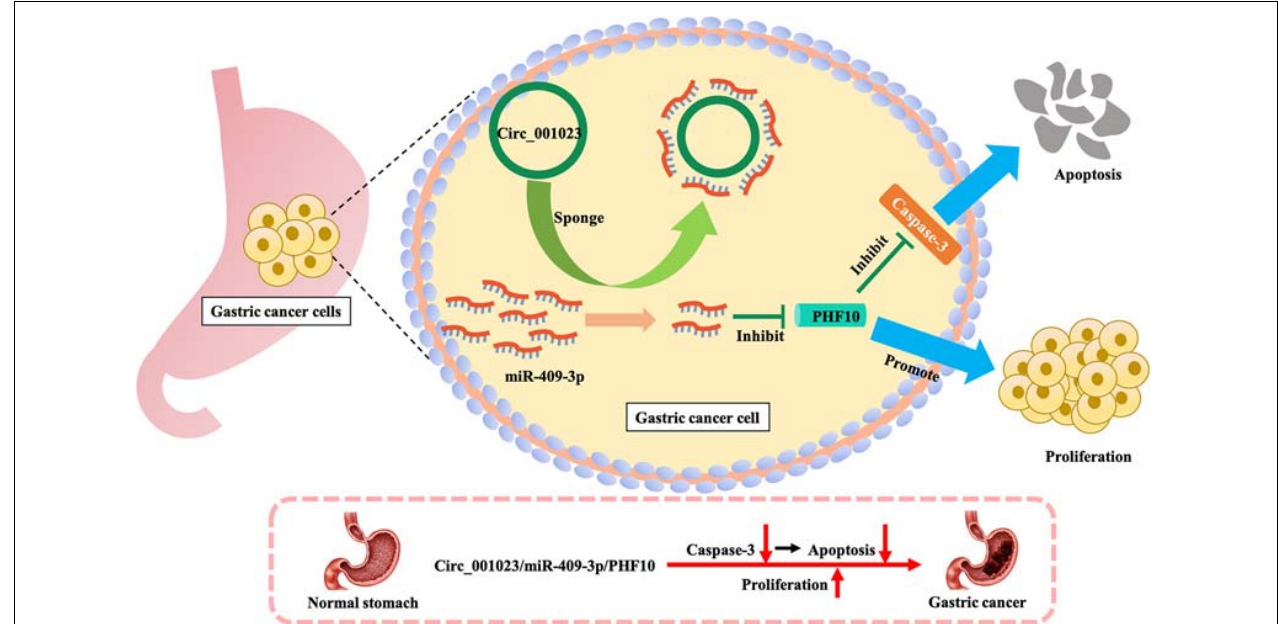
FIGURE 7 | Mechanism of promoting proliferation and inhibiting apoptosis of gastric cancer cells by